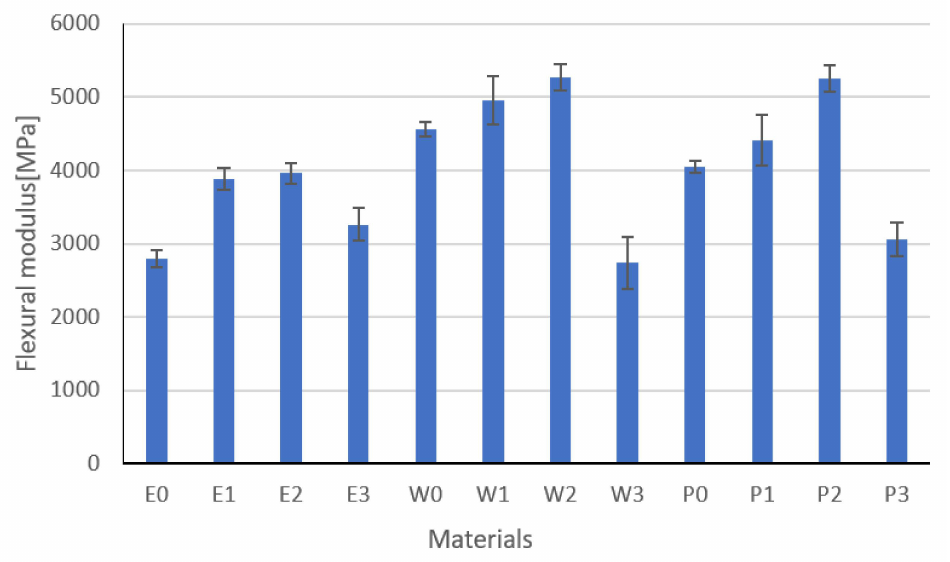
Figure 15. Flexural modulus